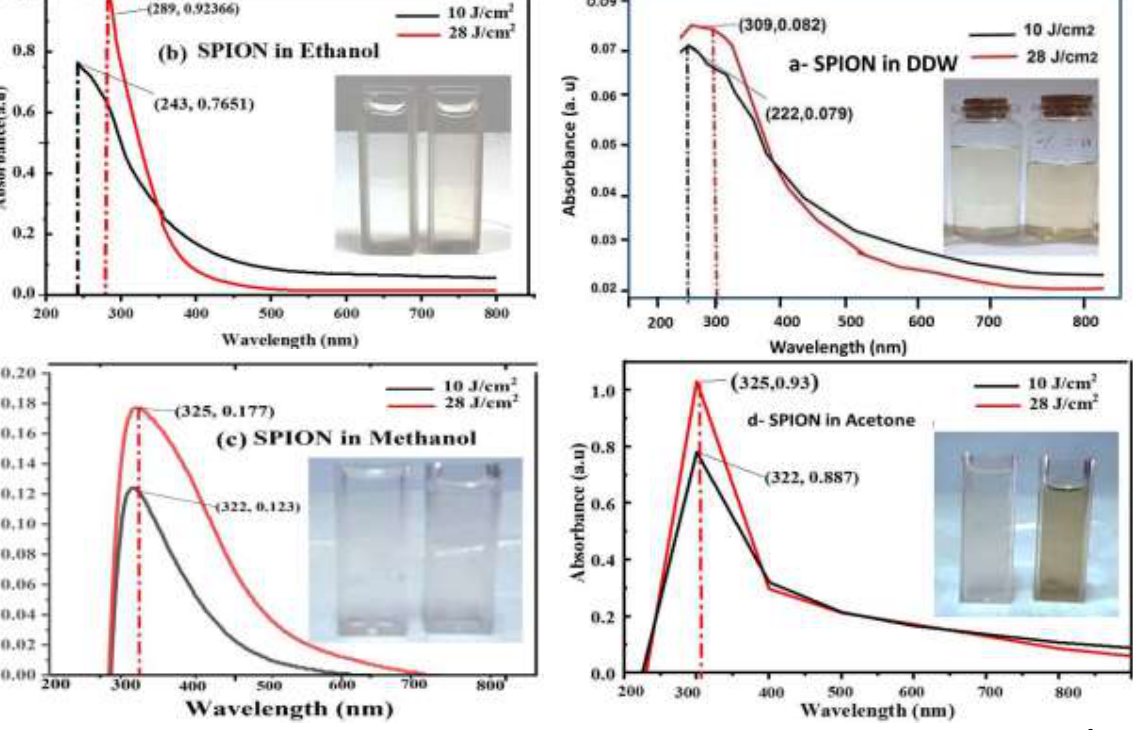
Figure 6: Absorbance spectra of SPION NPs prepared in different liquids with various fluences of 10 and 28 J/cm wavelength of 266nm. Insertion images show the coloration of the suspensions with variety of laser fluences (a- DDW,b- ethanol, c, methanol, and d-